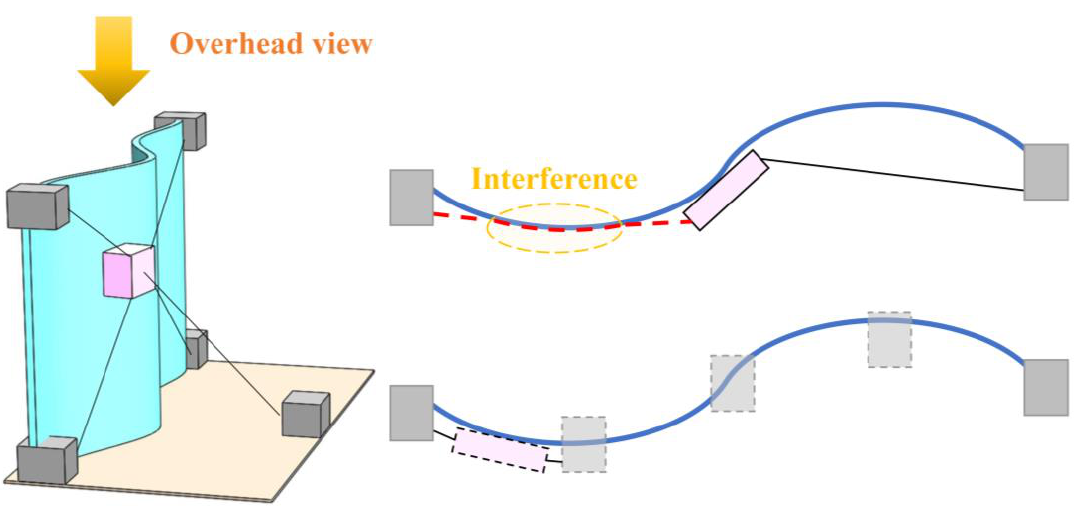
Figure 6. Interference problem between rope and wall surface.